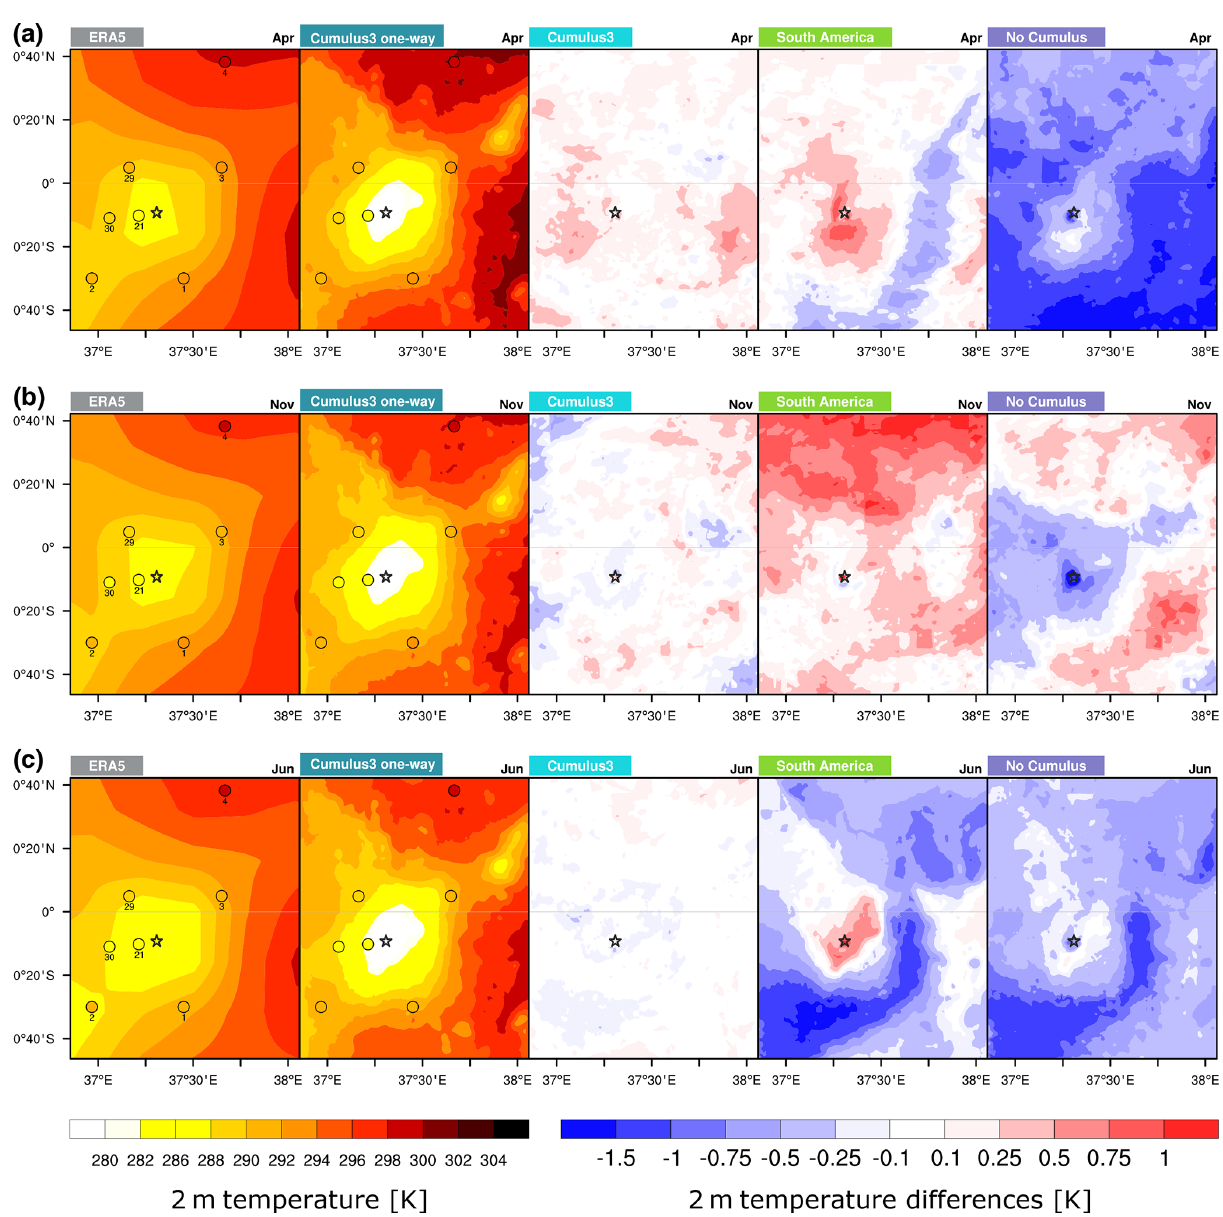
Figure 7. Monthly 2m temperature averages for (a) April 2008 (long rains), (b) November 2008 (short rains), and (c) June 2008 (dry season) in K are shown for the innermost domain (1km) of the nested four-domain setup, with the outermost domain of 27km resolution and a nesting ratio 1 : 3 for the different parameterization setups (Table 1). Absolute values are given for ERA5 and the Cumulus3 one-way option. The others depict differences compared to the Cumulus3 one-way option. Weather station data are described in Table 2. The black star indicates the summit of Mount